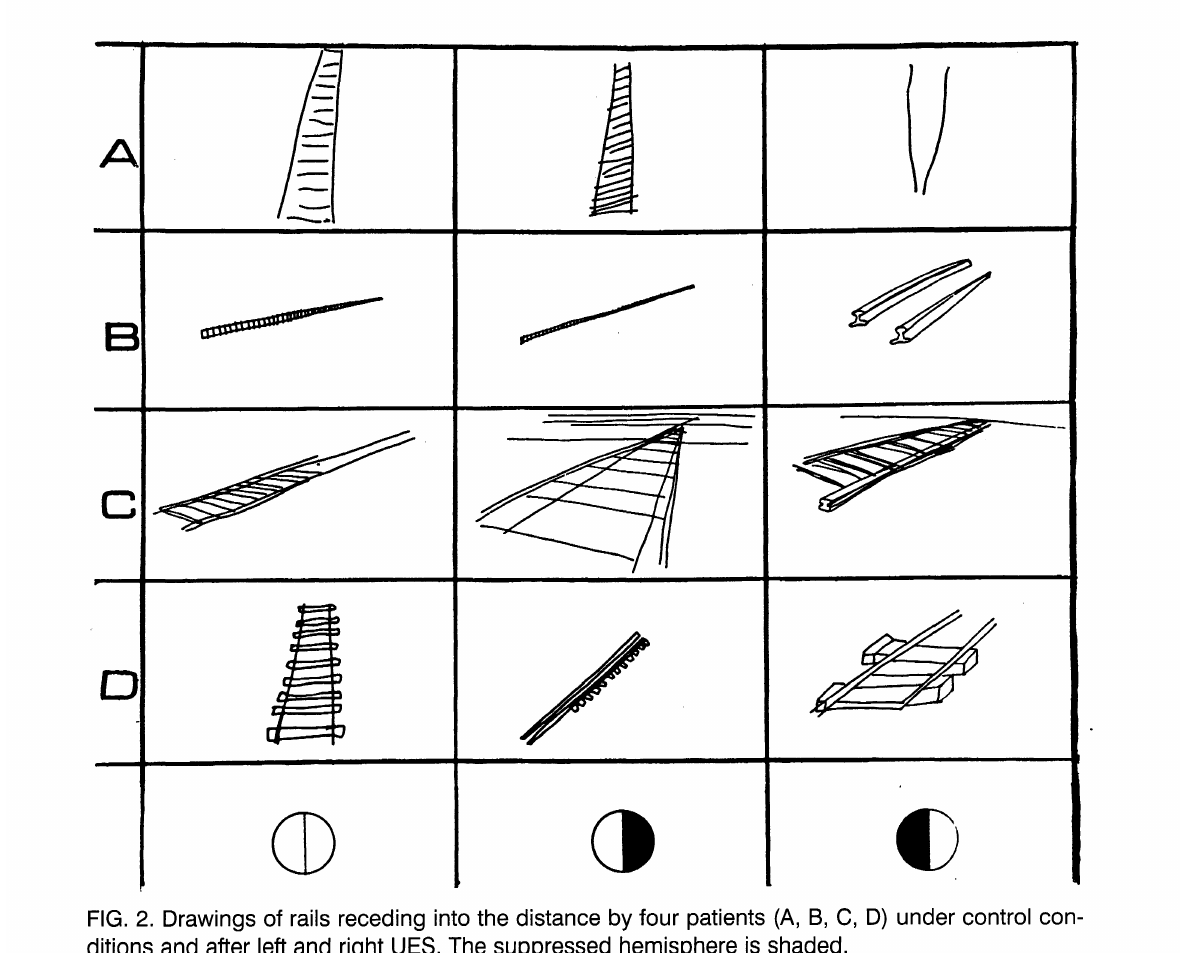
FIG. 2. Drawings of rails receding into the distance by four patients (A, B, C, D) under control con ditions and after left and right UES. The suppressed hemisphere is